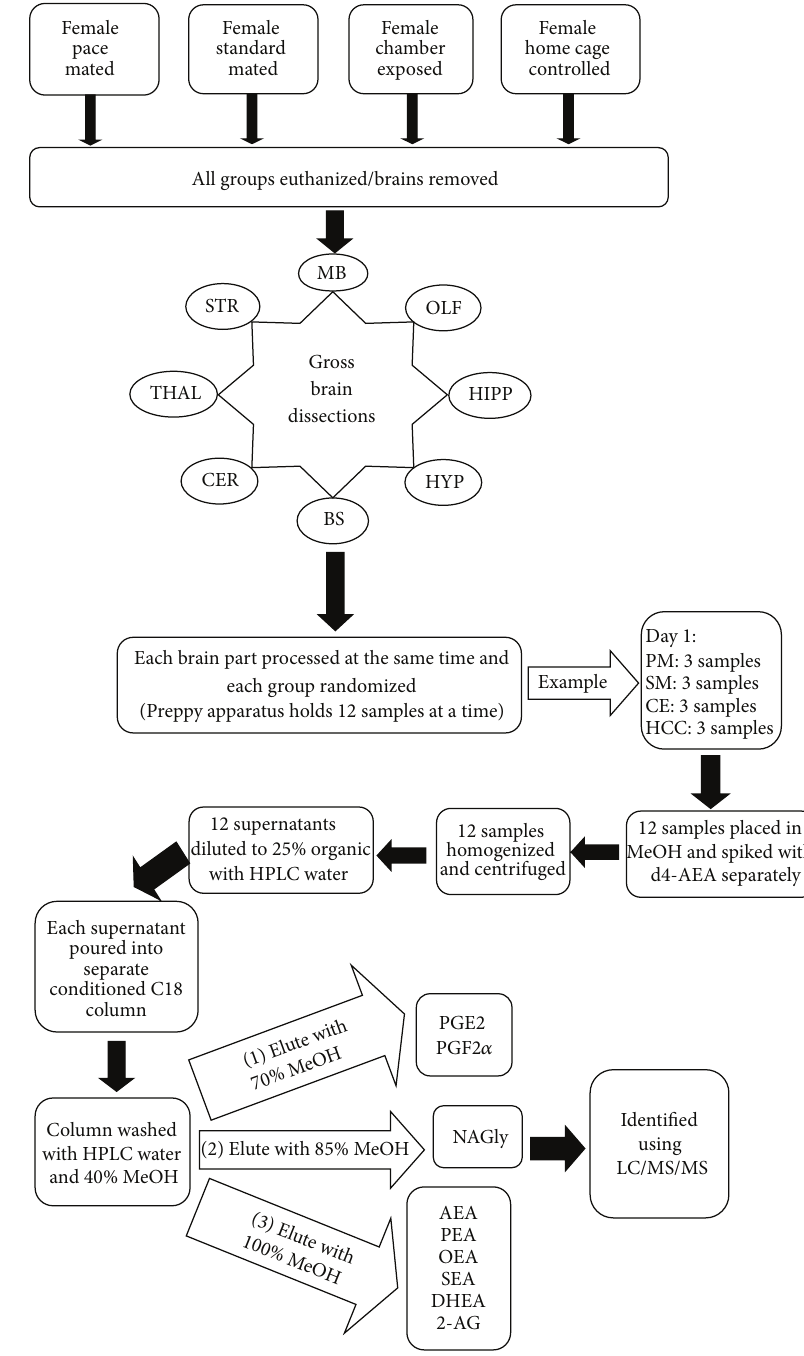
Figure 1: Flowchart of experimental design and lipidomic methodology—starting with the 4 different mating strategies treatment groups, euthanization and collection of brains, gross brain dissection, and then the randomization of the lipid extraction process to the standardized elution and HPLC/MS/MS analysis. See Section 2 for abbreviation